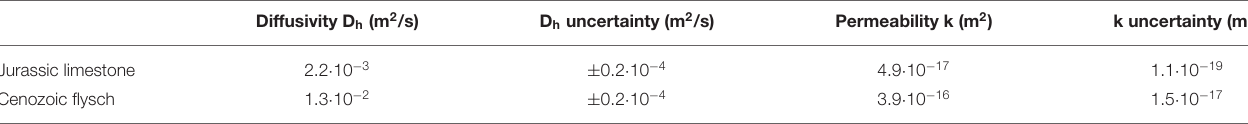
TABLE 2 | Hydraulic diffusivity (D h ) and permeability (k) calculated for the two regional rock formations crossed by the rays. Diffusivity D h (m 2